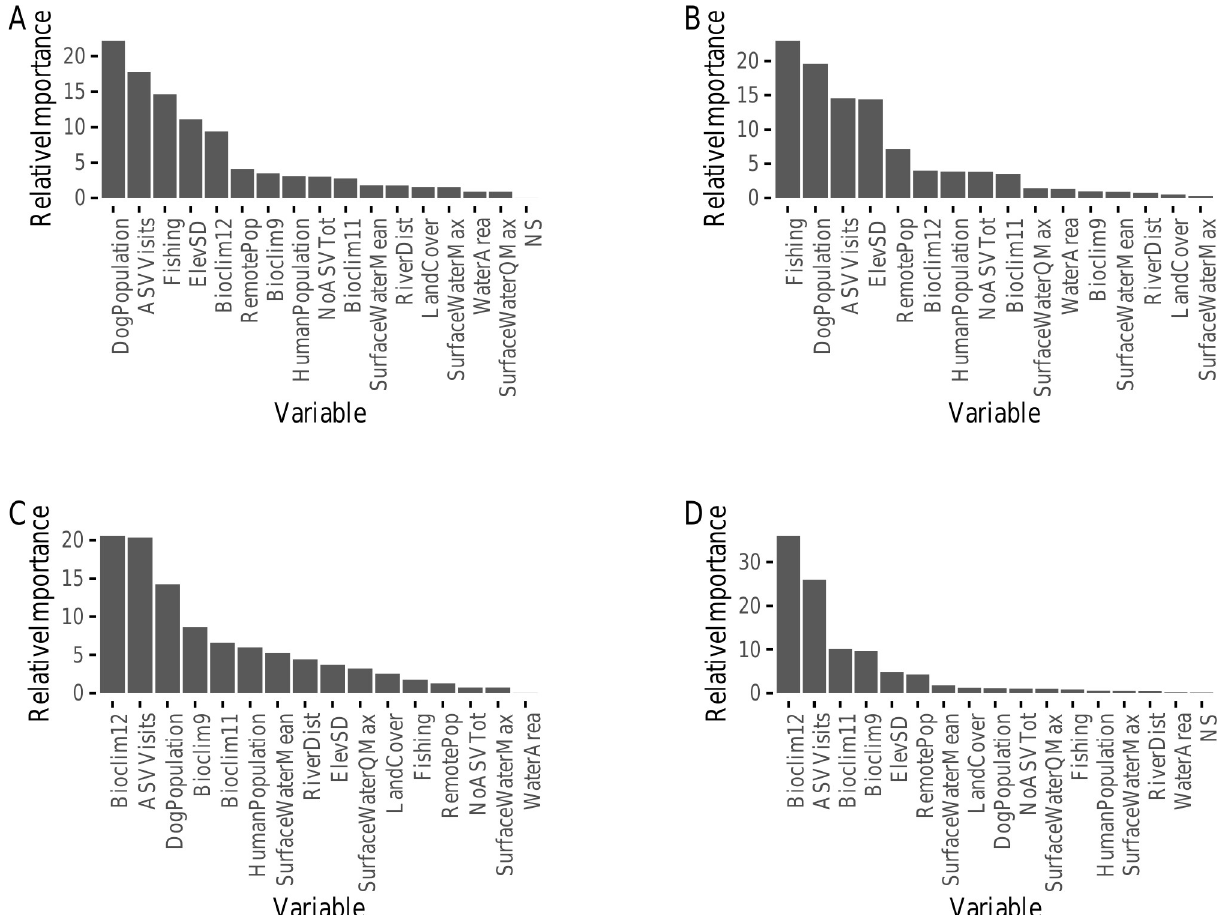
Fig 2. Relative importance estimates. Relative importance of covariates in predicting (a) D . medinensis infection presence in a village, (b) infection presence in Northern villages, (c) infection presence in Southern villages, and (d) hotspot identity across all villages. See S1 Table for notes on variable abbreviations (e.g. ASV Visits corresponds to the total number of healthcare supervisor visits to a village from 2013 to 2017).